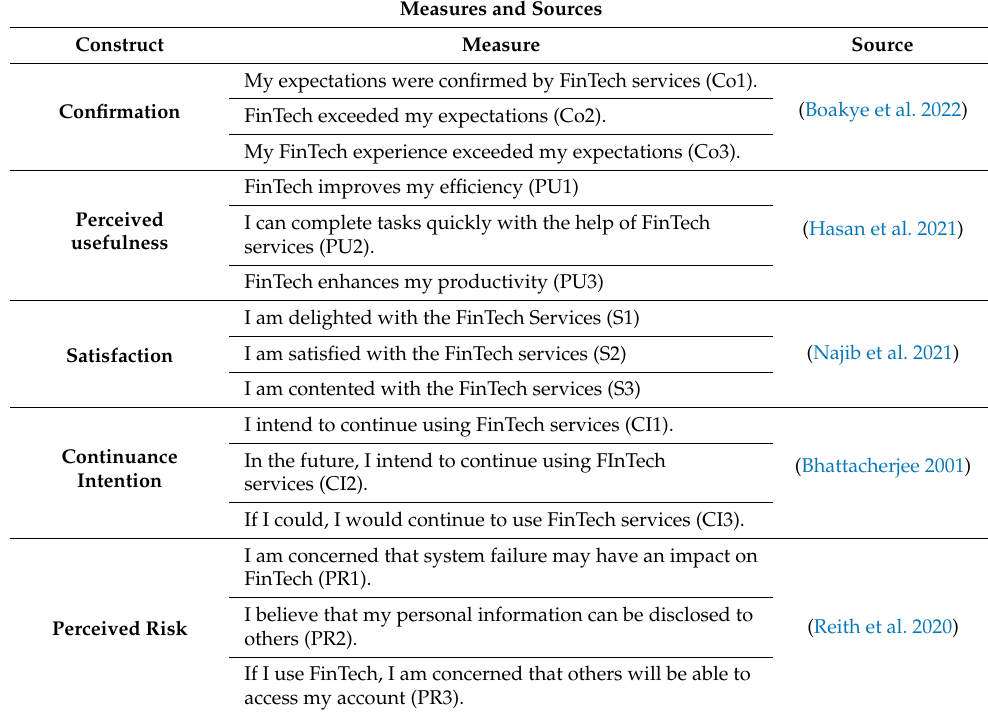
Table 2. Measurement items.